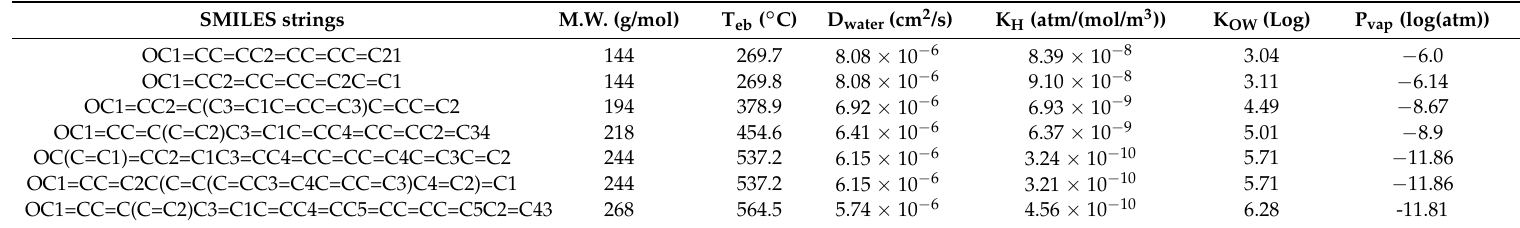
Table 1. Physical properties and partition coefficients of OH-PAHs evaluated using SPARC. (M.W. = molecular weight; T eb = boiling point; D water = diffusion coefficient of the analyte in water; K H = Henry’s constant; K ow = octanol-water partition coefficient; P vap = vapour